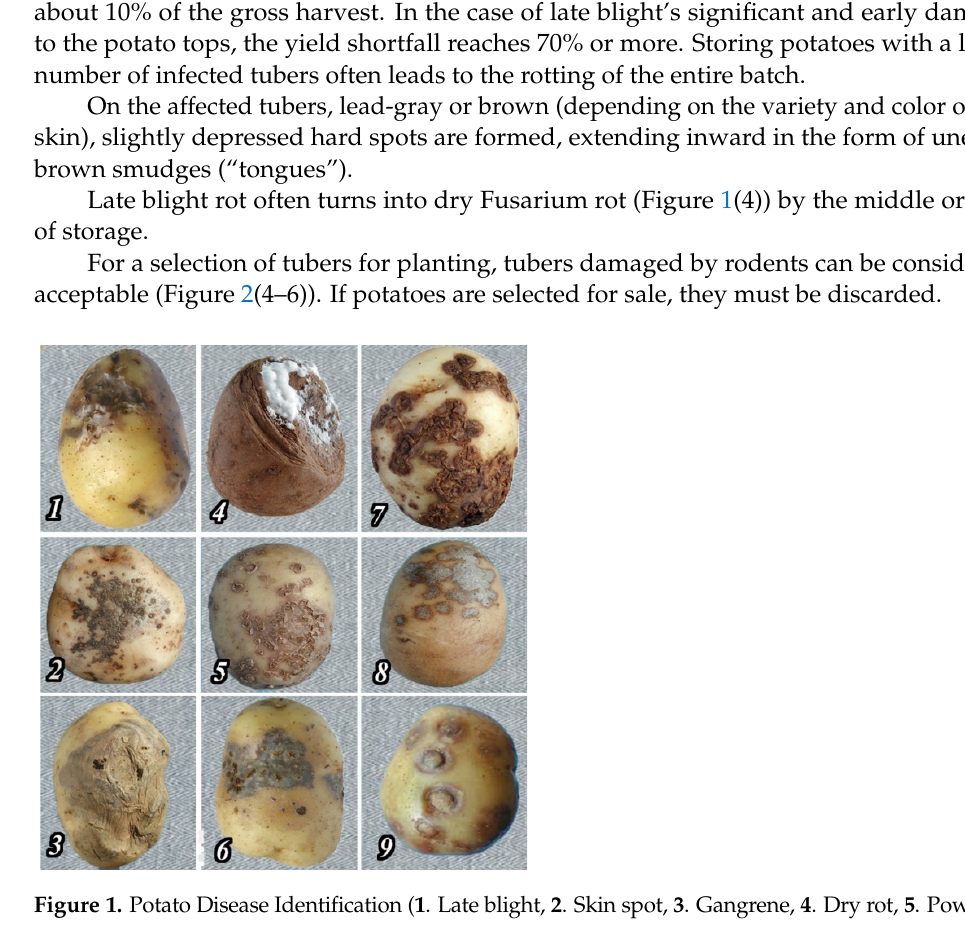
Table 1. Recommended speeds of the conveyor for root crops [18].